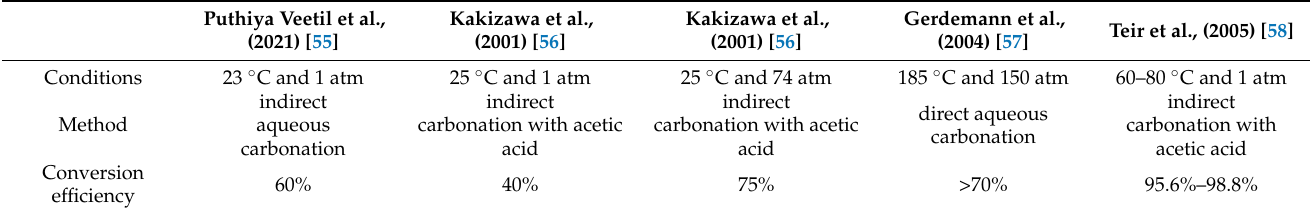
Table 1. Conventional precipitated calcium